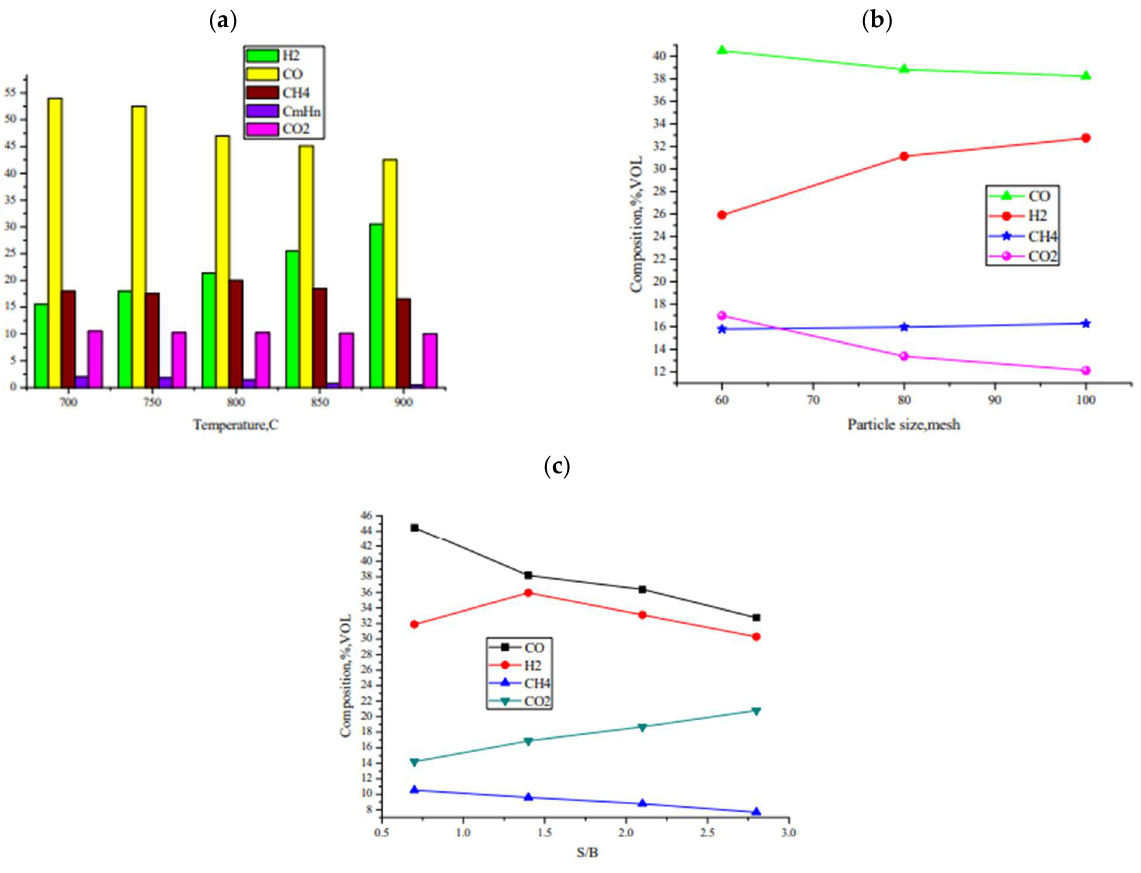
Figure 1. ( a ) Effect of temperature on gas composition, ( b ) effect of particle size on gas composition, ( c ) effect of steam to biomass ratio on gas composition [44].